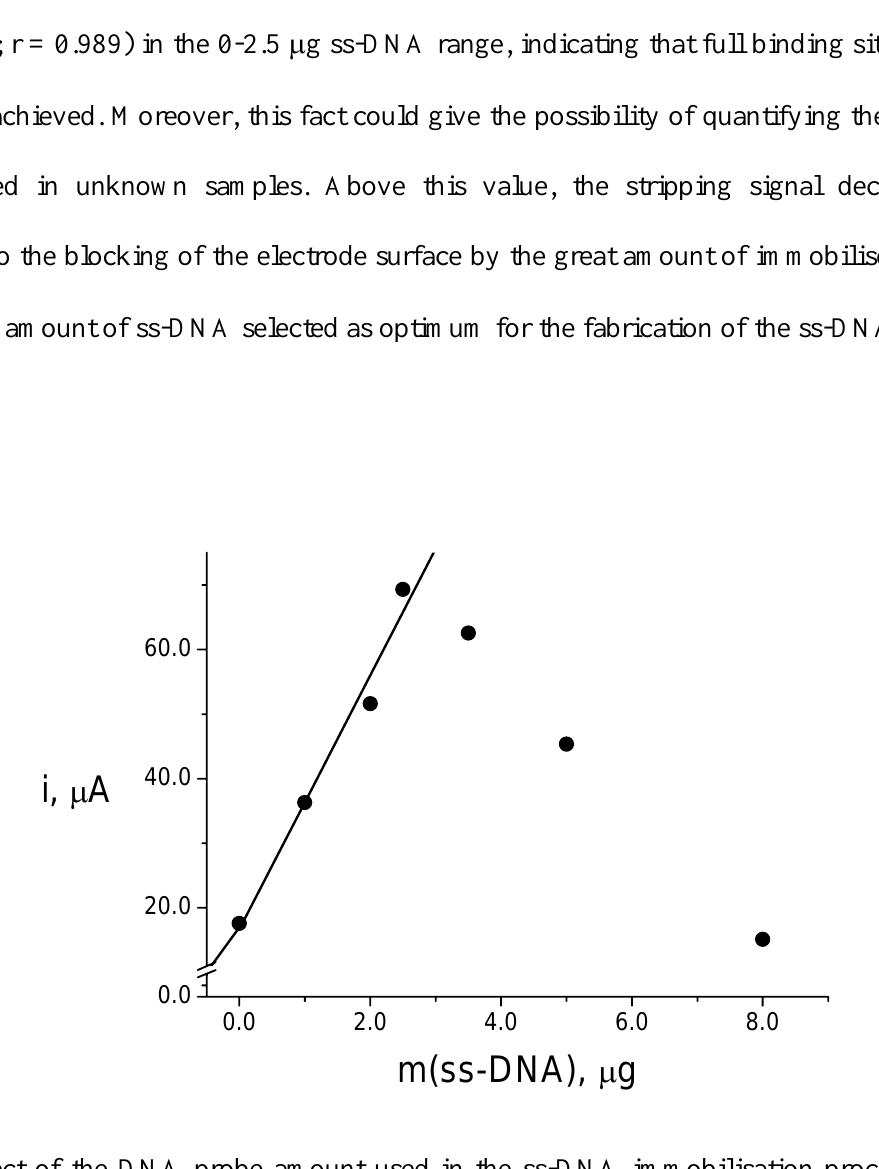
Figure 4. Effect of the DNA probe amount used in the ss-DNA immobilisation process on the MB anodic stripping SW peak current at the ss-DNA-EDC/NHSS-MPA-AuE. Supporting electrolyte: 50 mM Tris-HCl, 20 mM NaCl (pH 7.2). Immobilization conditions: t conditions: [MB] = 75 µ M, t = 1 min, open circuit. Measurement conditions: SWV ( ⎯ ), E acc mV, f = 100 Hz, v = 500 mV s -1